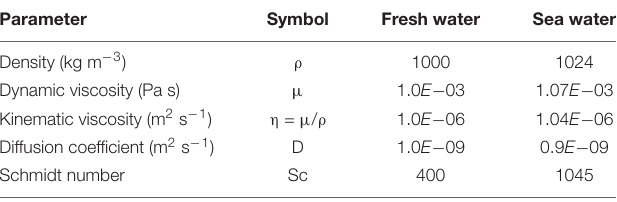
TABLE 4 | Parameters used for the calculation of the mass transfer coefficient.